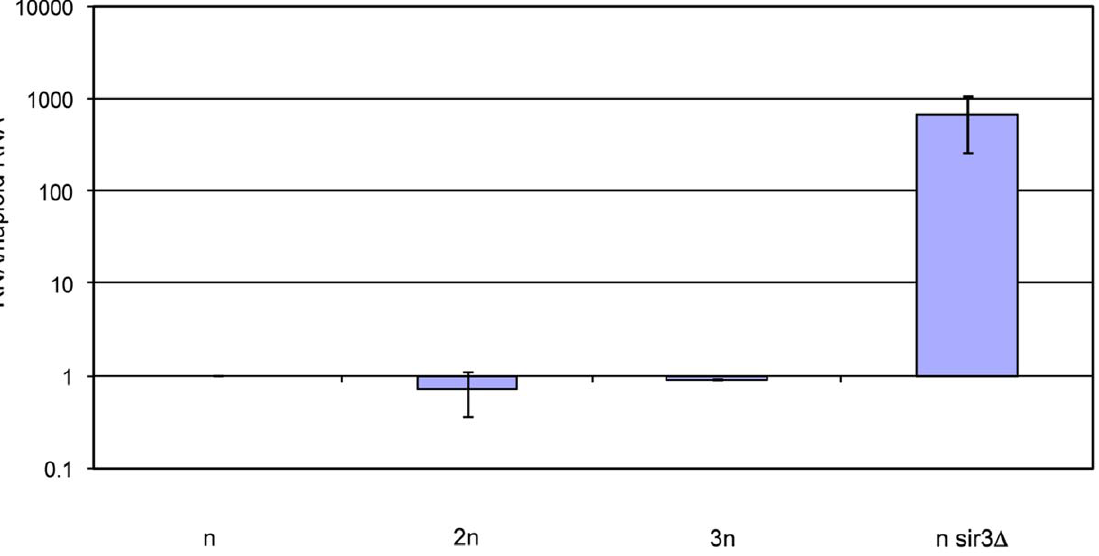
Figure 7. Transcriptional silencing at HML does not change with ploidy. mRNA levels were measured by QRT-PCR and compared to the levels in haploid cells. The values plotted are ratios to the amounts in the haploid cells. They are mean values from 3 separate RNA extractions. The error bars show 2 standard deviations.